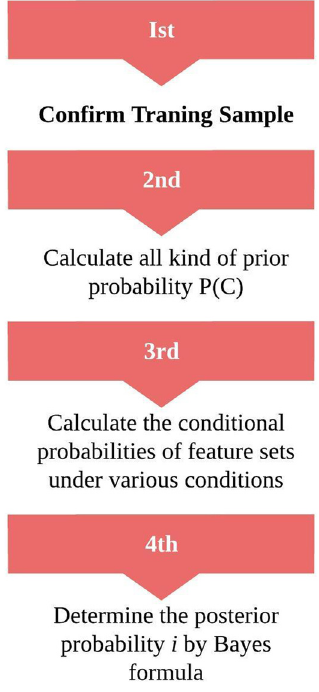
Figure 2: Training process of naive Bayesian